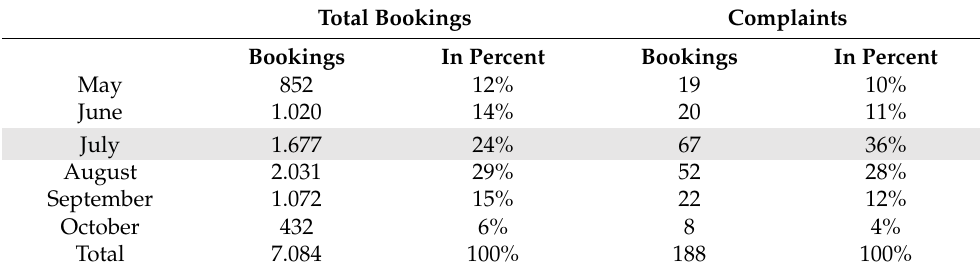
Table 2. Bookings 2018 by month.